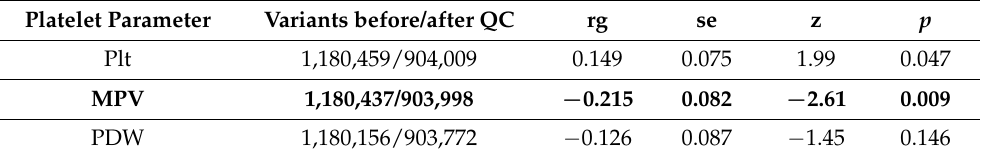
Table 1. Genetic correlations of platelet parameters with Parkinson-AAO. Platelet